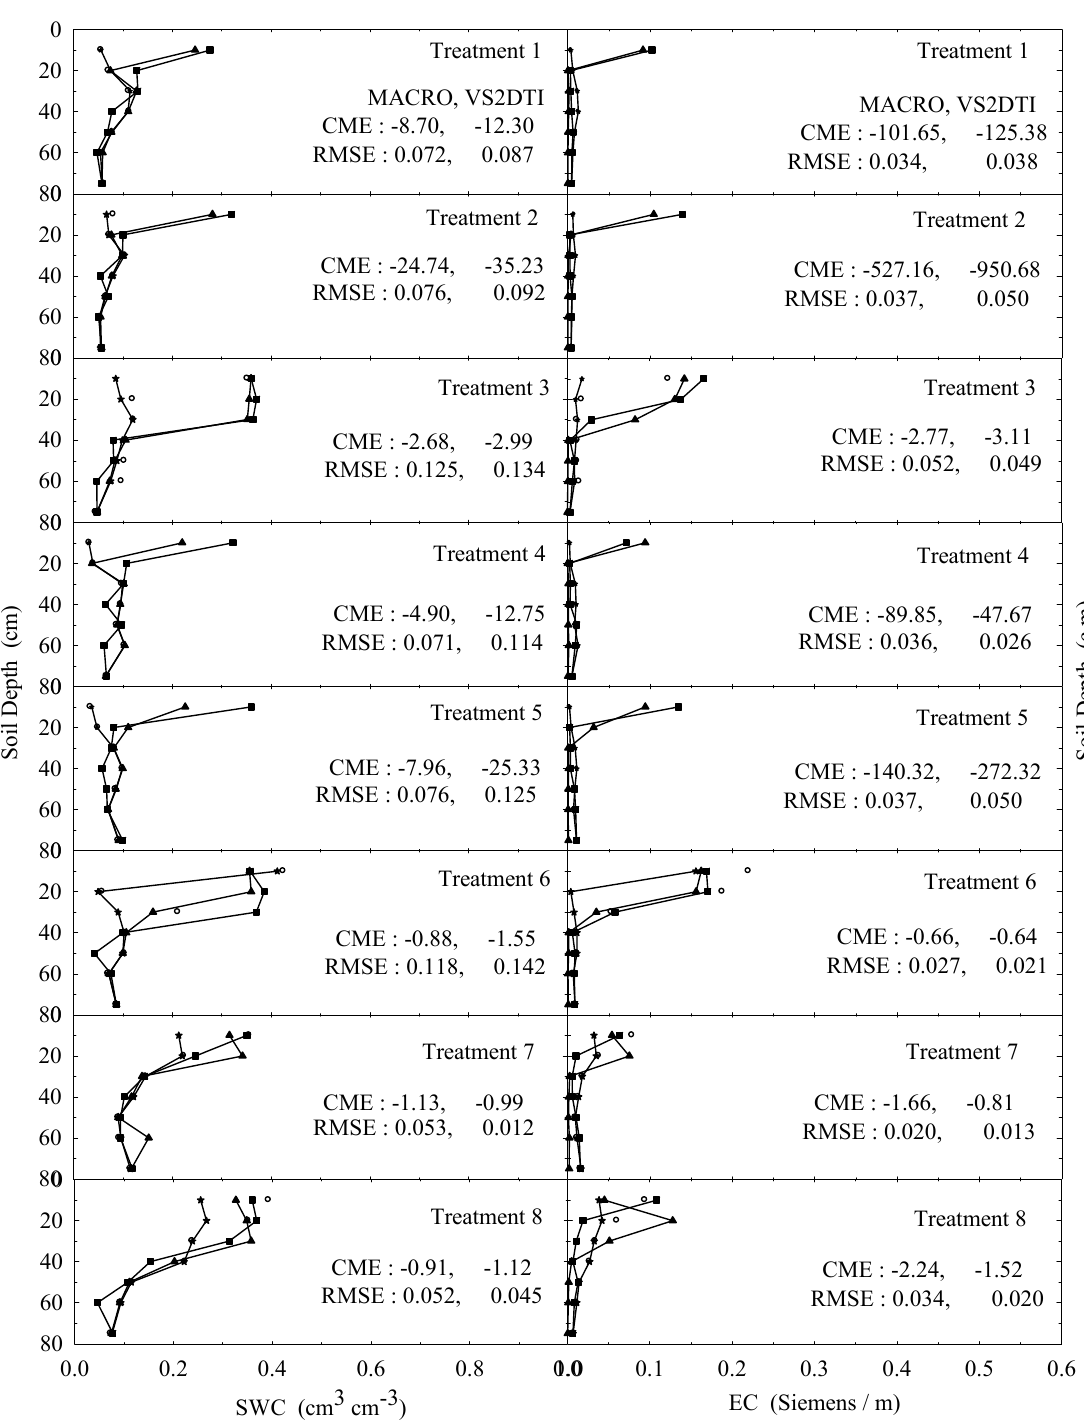
Figure 4. The variation of soil water content (SWC) and electrical conductivity (EC) with depth at 1 h of the experiment in the 8 treatments. The initial, measured, and model (MACRO and VS2DTI) values are exhibited by symbols ★ , ○ , ▲ , and ■ , respectively. CME and RMSE are the coeficient of model efficiency and the root mean square error,